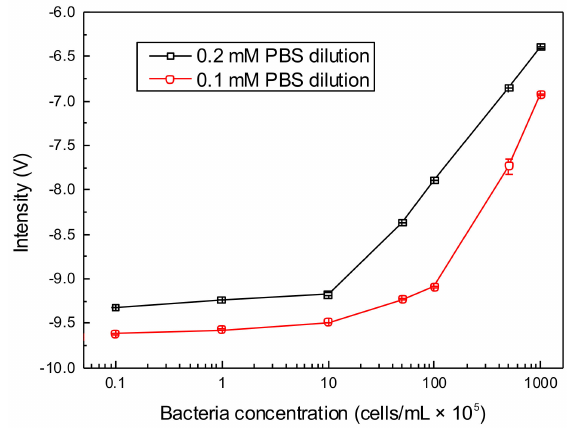
Figure 5. The C 4 D response to the bacteria suspended in 0.2 mM PBS dilution and 0.1 mM PBS dilution with the different concentrations of 10 4 –10 8 cells/mL. Error bars are standard deviations of four measurements.